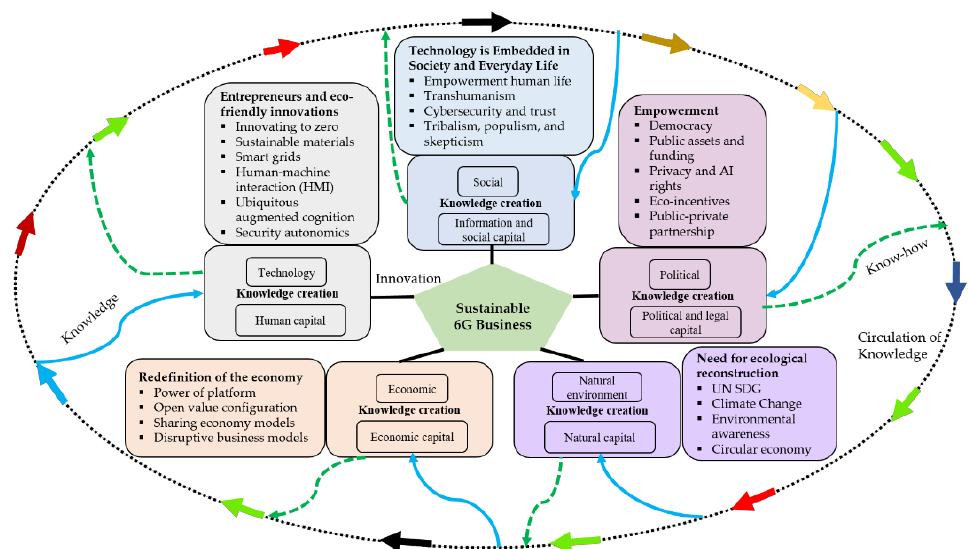
Figure 9. Useful choices for developing the preferred sustainable 6G business